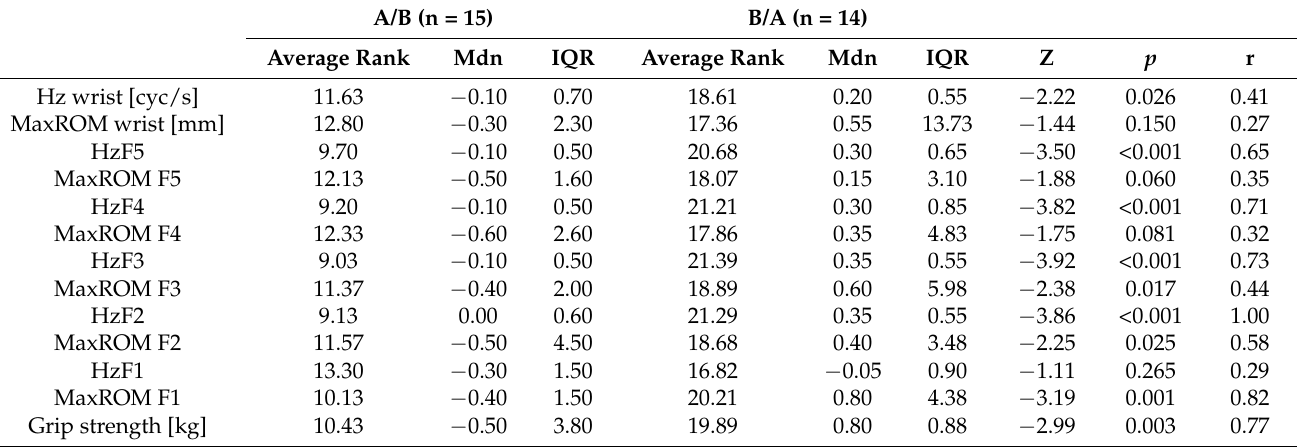
Table 6. Comparison of groups in terms of differences in parameters from the first and second measurement with